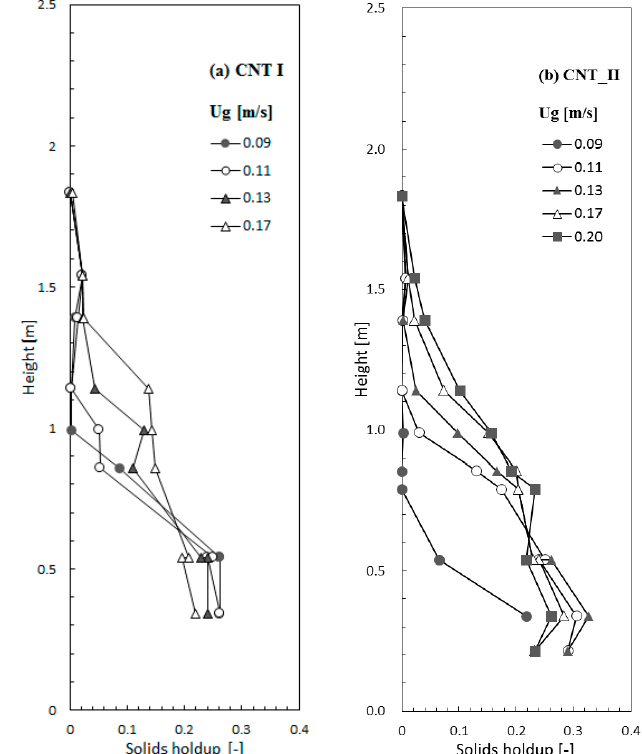
Figure 4. Axial solid holdup distributions of CNT particles with gas velocity ( a ) CNT I; ( b ) CNT II.